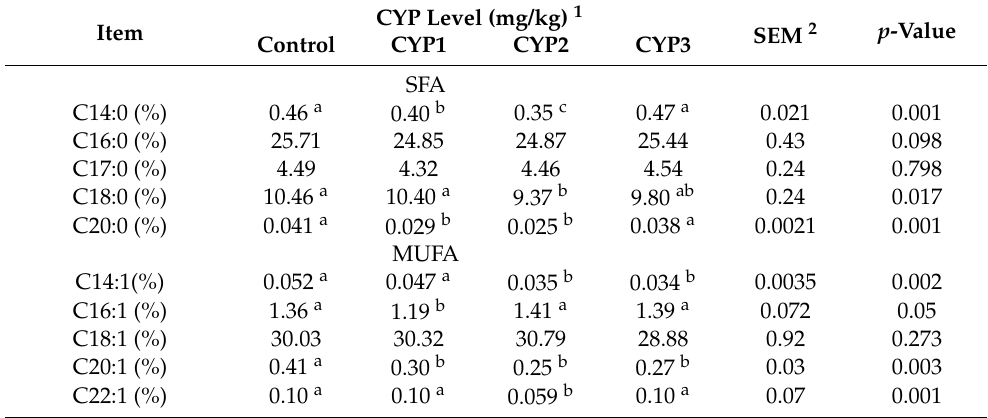
Table 4. Effects of CYP on fatty acids composition from breast muscle in